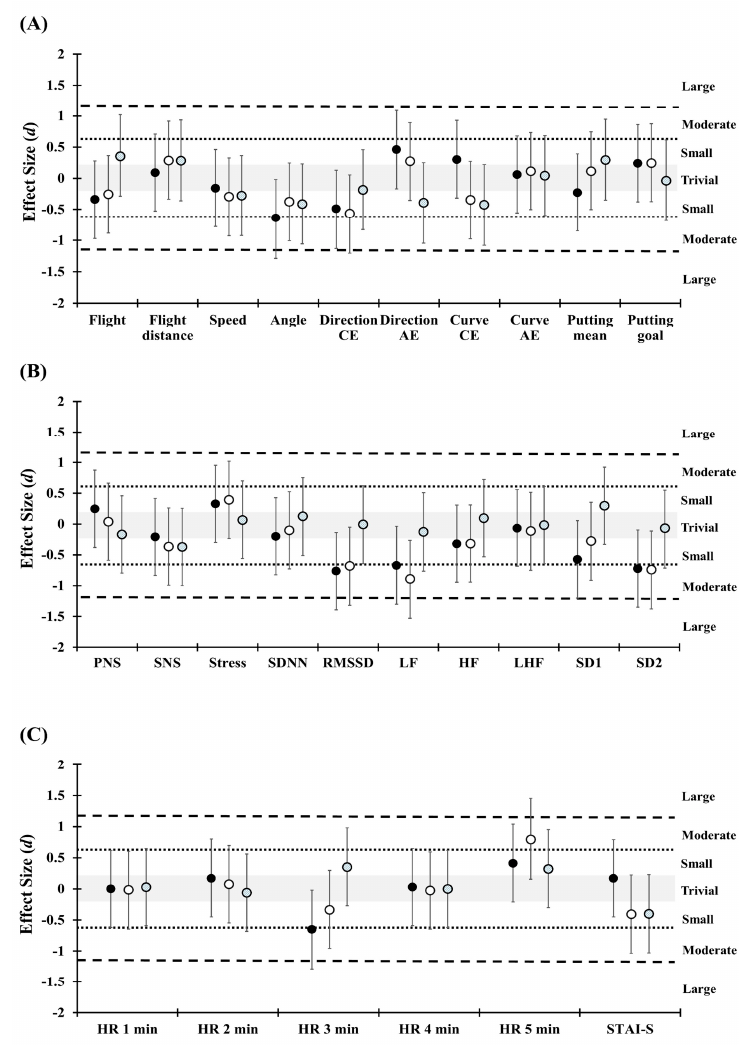
Figure 4. Standardized di ff erences (e ff ect size) of phase one and phase two percentage changes in the golf swing, golf putting, heart rate variability, heart rate, and state-trait anxiety inventory-state questionnaire between trials. ( A ) notes the e ff ect size in golf swing and putting performance; ( B ) notes the e ff ect size in heart rate variability variables; ( C ) notes the e ff ect size in heart rate responses and anxiety level. The positive values of e ff ect size indicate A value greater than B value and vice versa. Grey area represents trivial e ff ect size. The black full circle indicates comparison between non-music trial and pre-exercise music trial. The open circle indicates comparison between non-music trial and simultaneous music trial. The grey circle indicates comparison between non-music trial and simultaneous music trial. CE = constant errors; AE = absolute errors; PNS = parasympathetic nervous system index; SNS = sympathetic nervous system index; SDNN = standard deviation of normal R-R interval; RMSSD = root mean square of successive RR interval di ff erences; LF = low frequency power spectrum; HF = high frequency power spectrum; LHF = low frequency and high frequency ratio; SD1 = the standard deviation of the points perpendicular to the line of symmetry; SD2 = the standard deviation of the points along the line of symmetry; HR = heart rate; STAI-S = state-trait anxiety inventory-state questionnaire.